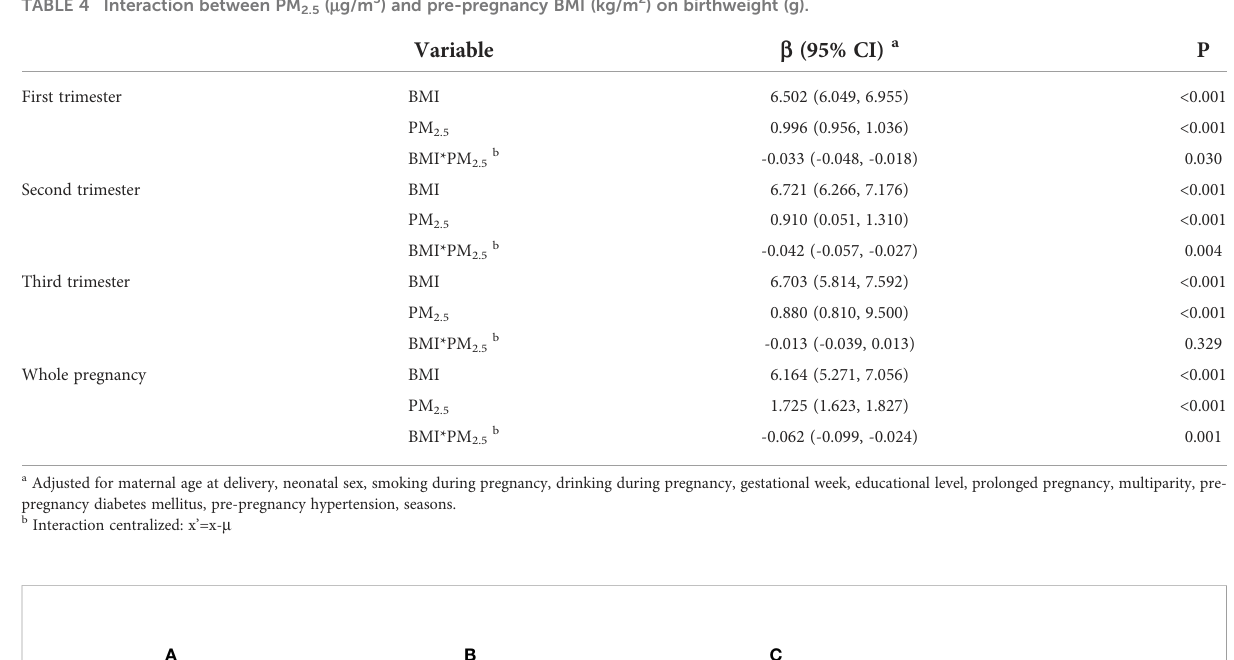
TABLE 4 Interaction between PM 2.5 ( m g/m 3 ) and pre-pregnancy BMI (kg/m 2 ) on birthweight (g).